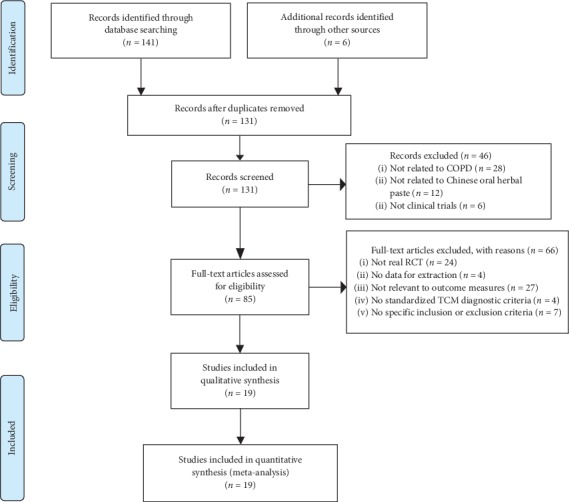
Study flow chart.